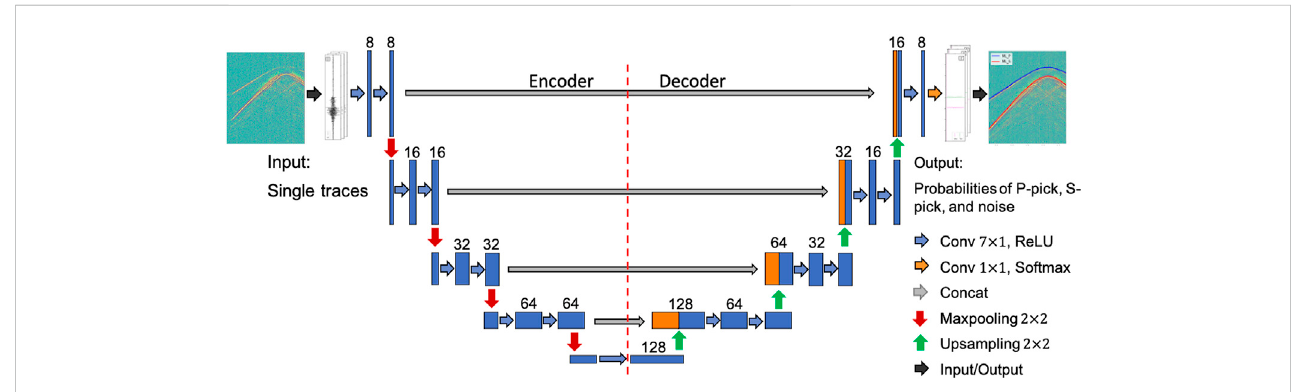
FIGURE 5 U-Net architecture for arrival-time